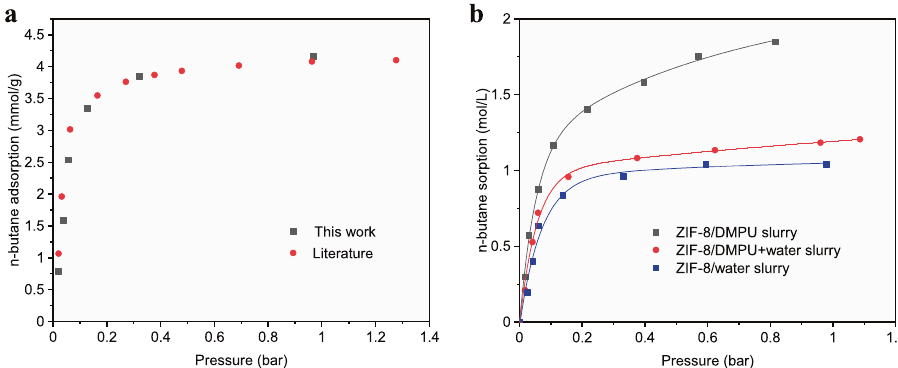
Fig.2|n-butanesorptioncapacity. Sorptionisothermsofn-butaneon a ZIF-8powderat293.15Kmeasuredinthisworkandtheliterature 31 , b ZIF-8(35wt%)/DMPUslurry, ZIF-8 (25 wt%)/water slurry and ZIF-8 (30 wt%) slurry with solvent composition of 80 wt% DMPU + 20 wt% water at 293.15 K. The lines are guides for eyes.